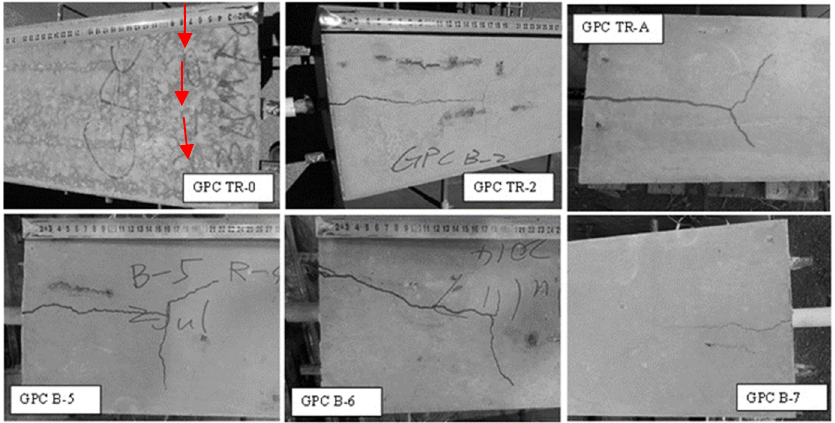
Figure 7. Examples of top face cracks in GPC beams (faint cracks are highlighted by red arrows).